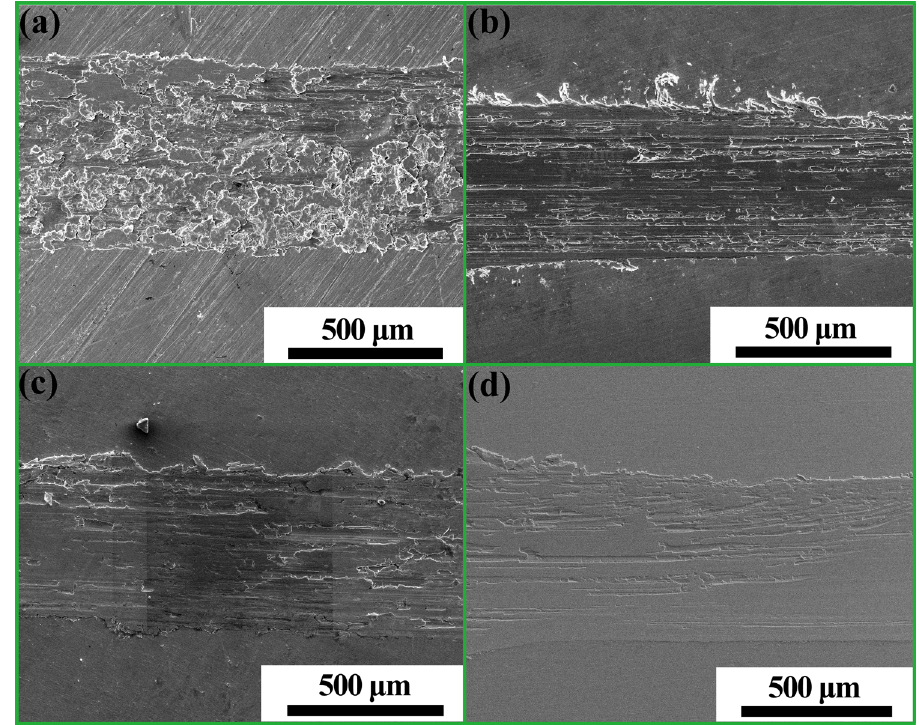
Figure 6: SEM images of the friction - wear morphologies of Cu – Cr – Ti after being treated by ( a ) ST, ( b ) ITOX, ( c ) ST + 80% + aging, and ( d ) ITOX + 80% +